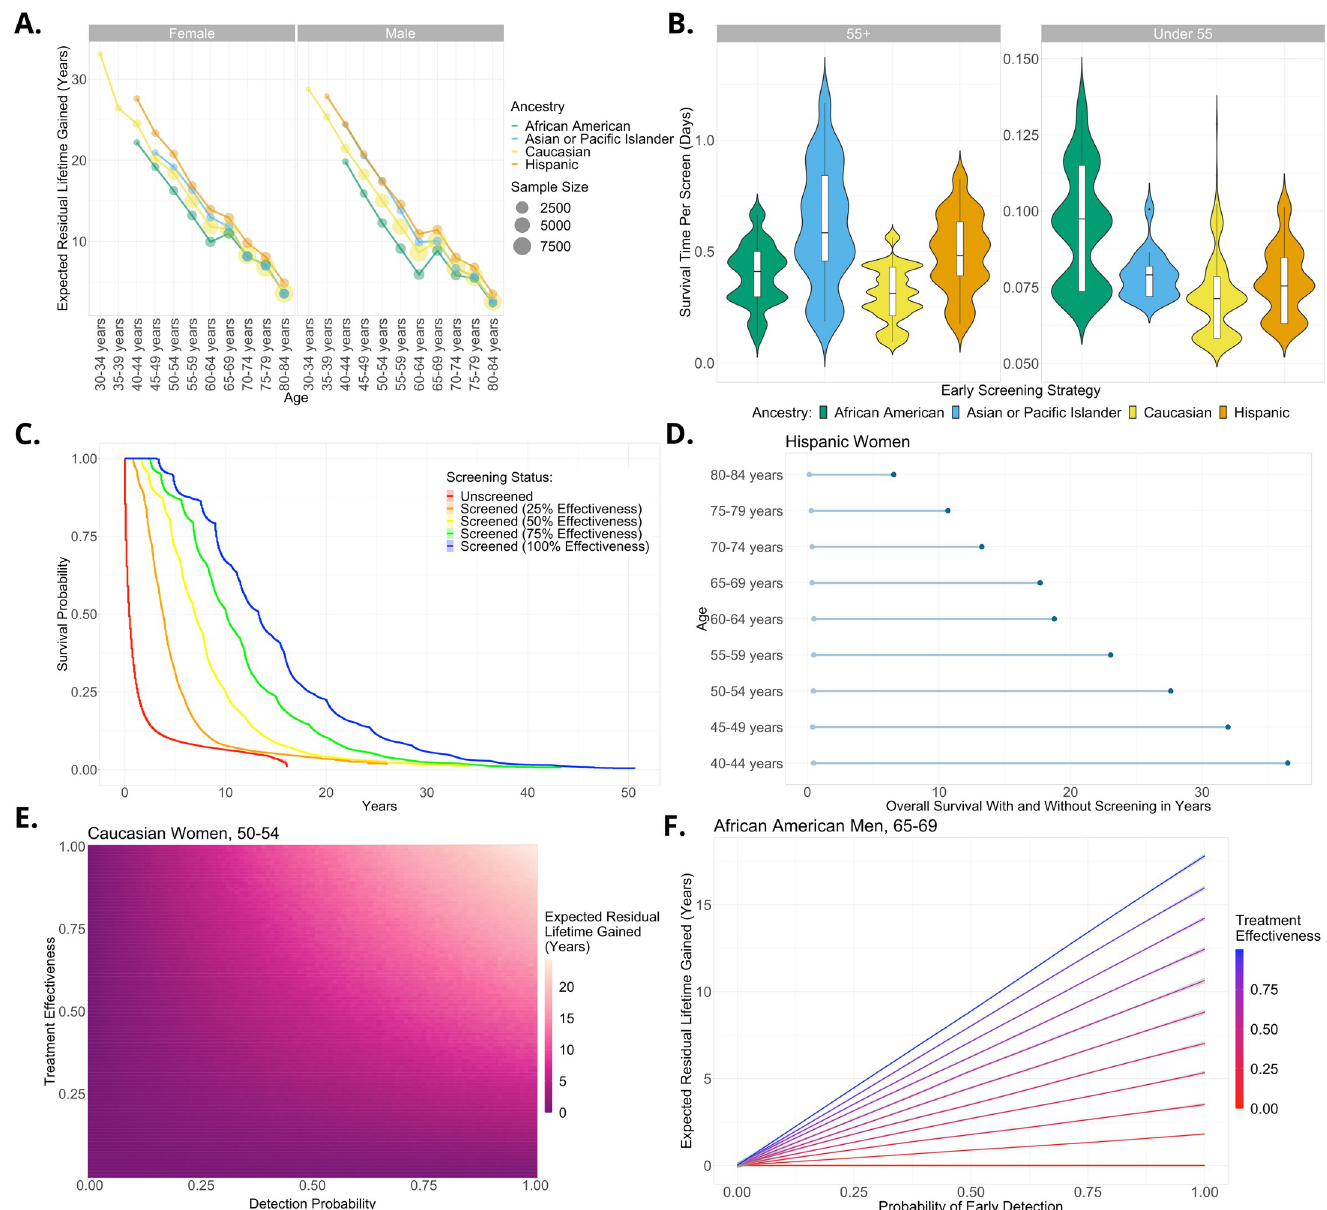
Fig 2. Survival benefits of screening for pancreatic cancer under a range of scenarios. (A) Overall survival benefit conferred from an example scenario of pancreatic cancer screening stratified by sex, ancestry, and age assuming that early screening never yields false negatives and identifies cancer early enough to achieve 75% effectiveness (survival to 75% of the average life expectancy for that group on average). The slight upward bump at age 65 is due to the conditional survival distribution given having lived to a certain age and its discrete stratification (Materials and Methods). (B) Under the assumptions of panel A we compare various screening programs targeted at different population subgroups based on age and ancestry. The survival benefit per pancreatic cancer screen (i.e., incidence adjusted) is shown. (C) Survival curves comparing overall survival from screens with different levels of effectiveness and the unscreened. (D) Difference in overall survival with (right dot) and without (left dot) screening for Hispanic women under assumptions of panel A. (E) Overall survival benefit for Caucasian women, aged 50–54 as a function of screen detection probability and resultant treatment effectiveness. The color of the heatmap represents the expected residual lifetime gain and is calculated exactly from the model. (F) Overall survival benefit to African American men, aged 65–69 as a function of model parameters: detection probability and resultant treatment effectiveness. Each contour represents a different scenario of benefit of early detection. Increasing the screen sensitivity and resultant treatment effectiveness can drastically change predicted overall